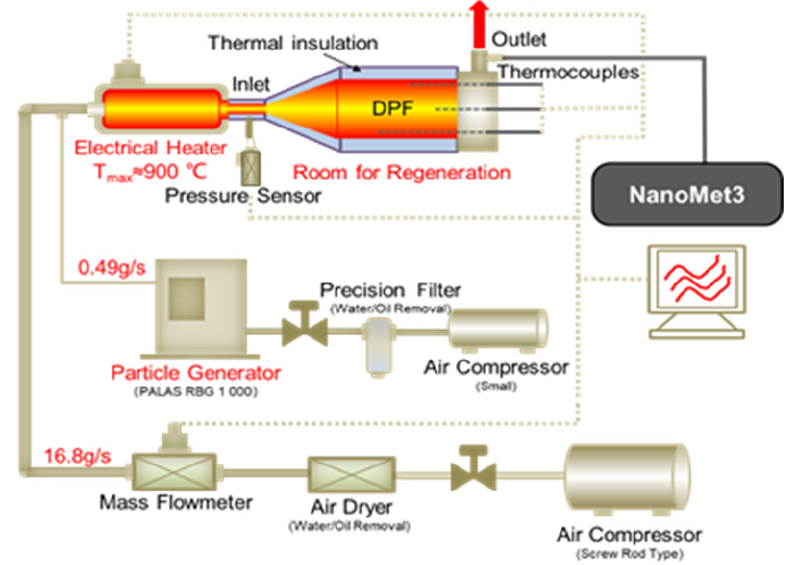
Figure 2. Schematic of the DPF regeneration test bench.